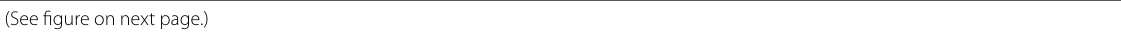
Fig. 7 The morphology of dopaminergic neurons, number of viable dopaminergic neurons, TH protein level, and the formation of Lewy bodies in substantia nigra of rotenone-induced PD mouse model transduced with NDI1. A The morphology of dopaminergic neurons in the right SNpc was examined using H&E staining. Dopaminergic neurons were indicated with circles. (Scale bar: 50 μm). B The presence of viable dopaminergic neurons in the SNpc (indicated with circles) and VTA (out of circles) was examined using TH immunohistochemistry. Brain sections were stained with TH antibody. TH-positive cells were counted to evaluate viable dopaminergic neurons. Scale bar 500 μm. C – F Statistical analysis of the = number of TH-positive dopaminergic neurons in the left and right VTA, and in the left and the right SNpc. G TH protein in the SN was examined by western blot using TH antibody with GAPDH as loading control. H , I Quantitative analysis of the TH level in the left and right SN. J The formation of Lewy bodies in dopaminergic neurons of right SNpc was examined by pS129 α -synuclein immunohistochemistry. The arrow showed Lewy body (brown). Rotenone vector group compared with CMC vector group, or CMC NDI1 group compared with CMC vector group, or + + + + Rotenone NDI1 group compared with Rotenone vector group, or Rotenone NDI1 group compared with CMC vector group, ns not + + + + significant, * P < 0.05, *** P < 0.001. SNpc substantia nigra pars compacta, VTA ventral tegmental area, TH